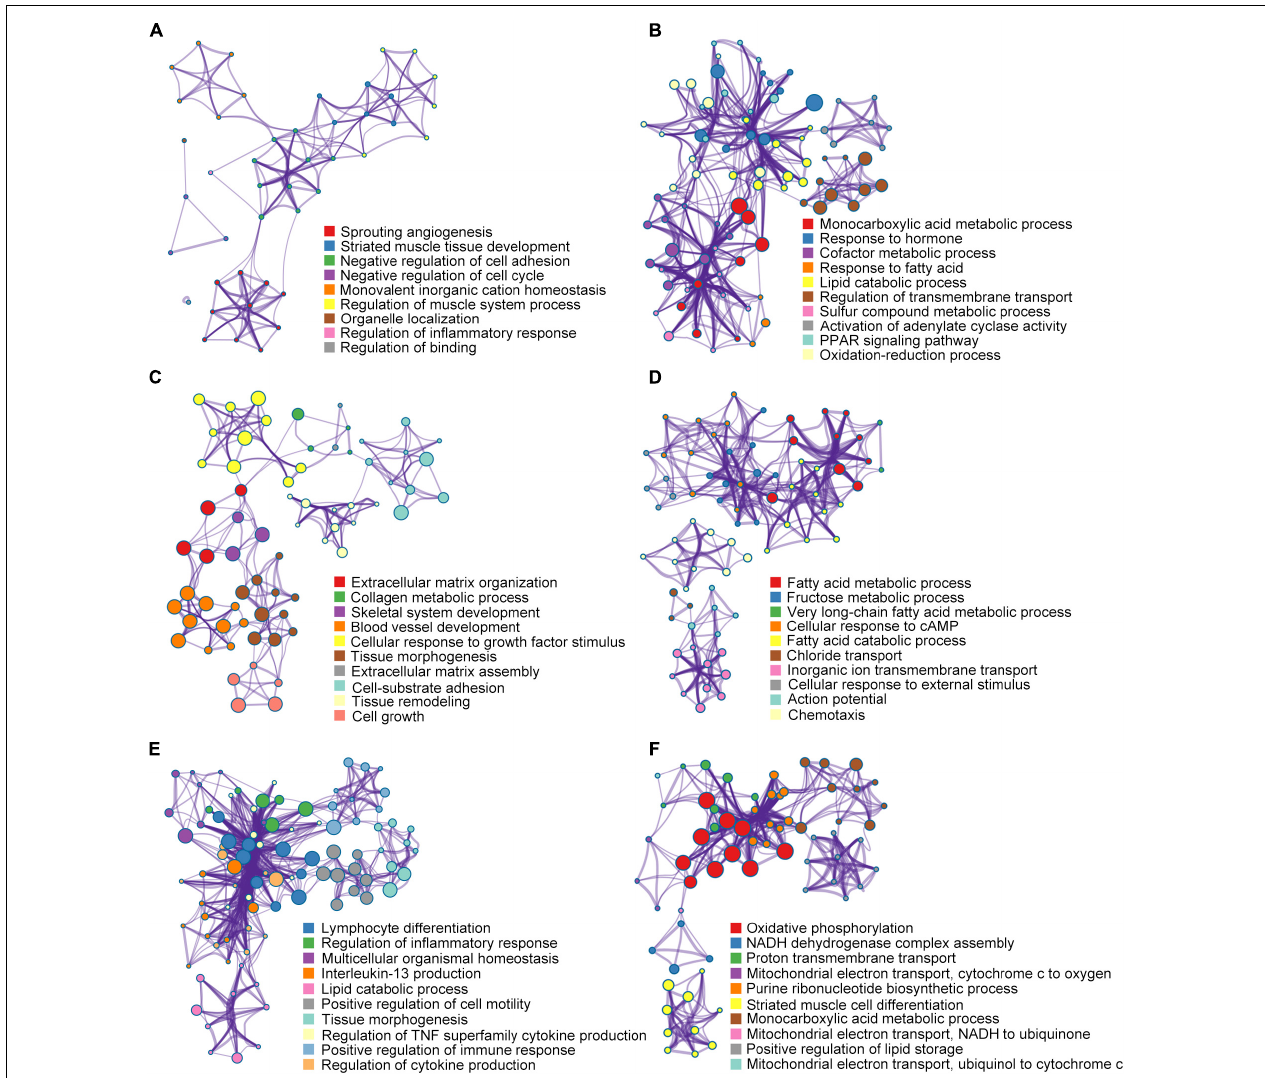
FIGURE 8 | Gene set enrichment analysis for DEGs. In the 2W-post-TAC hypertrophic hearts, a biological process enrichment analysis of the DEGs (2W-post-TAC vs. sham) revealed augmentation mainly in cardiac remodeling and immune response (A) , and suppression in metabolism and cardiac regulation (B) . In the 4W-post-TAC HFpEF groups, the DEGs (4W-post-TAC vs. sham) were found to be augmented in cardiac remodeling, and suppressed in metabolism (C) , contractile regulation and immune response (D) . In the 8W-post-TAC HFrEF hearts, the enhanced biological processes included immune response, cardiac remodeling, and lipid catabolism (E) , and the depressed biological processes included mitochondrial function, cardiomyocyte growth and lipid storage (F) . N = 2 for the sham, 2W-, 4W-, and 8W-post-TAC groups. N = 2 for the sham, 2W-, 4W-, and 8W-post-TAC